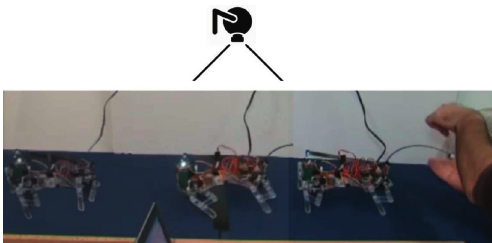
Figure 5: The experimental setup. A camera extracts the robot’s